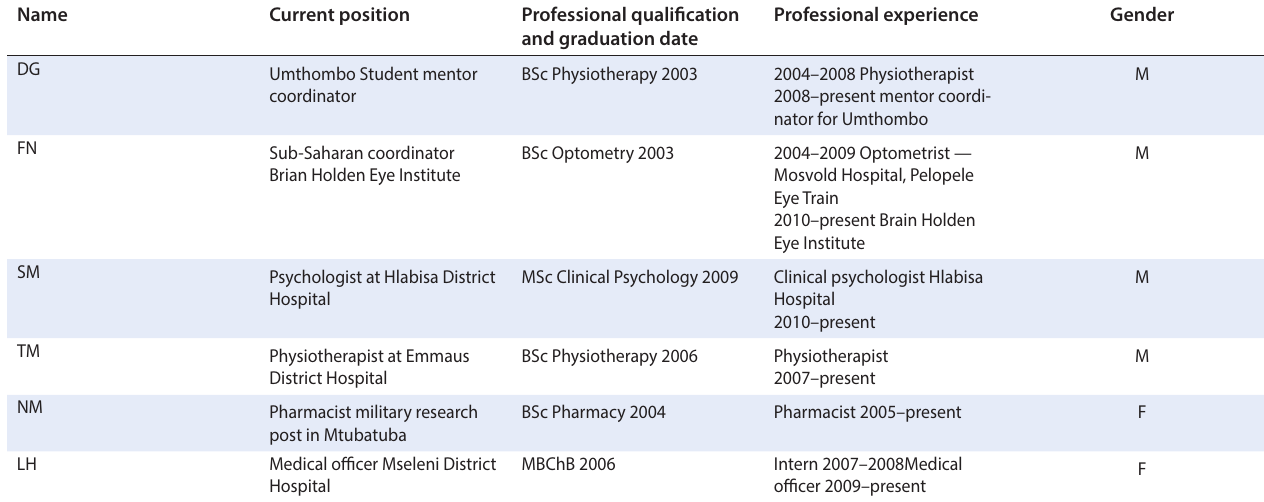
Table 1: Healthcare professionals who participated in the study Name